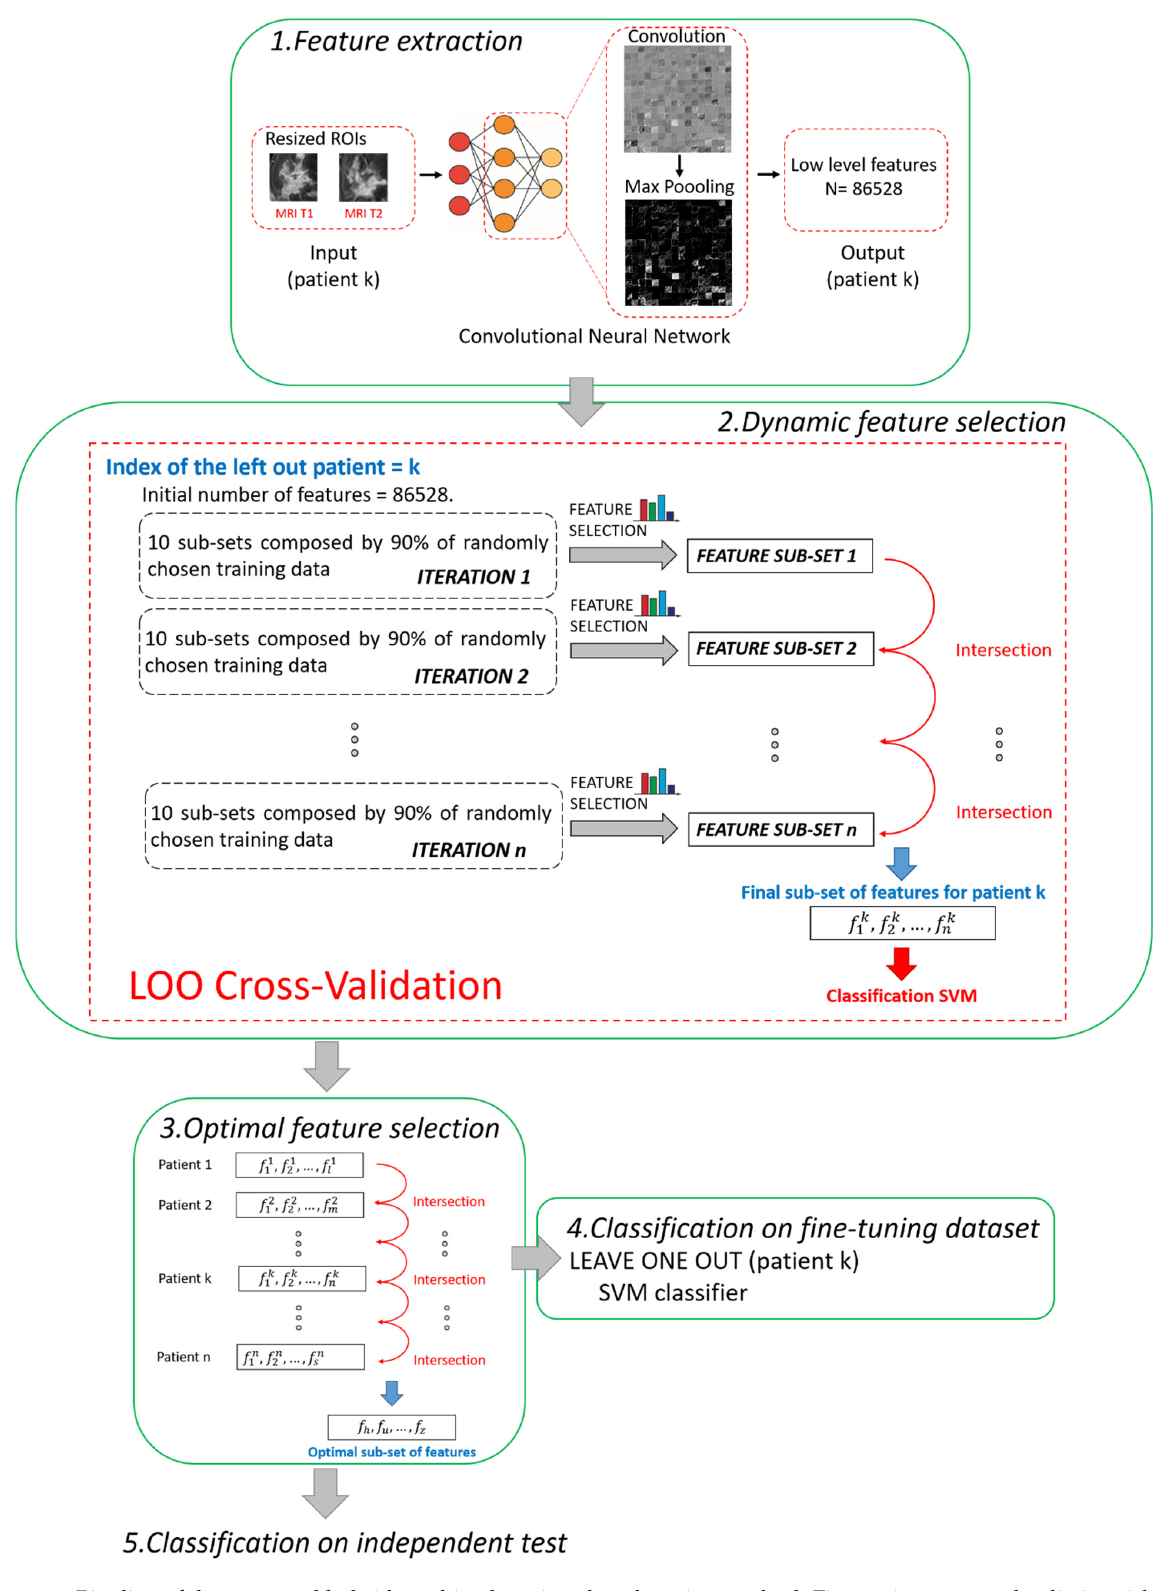
Figure 2. Pipeline of the proposed hybrid machine learning-deep learning method. Five main steps can be distinguished: 1. Feature extraction, 2. Dynamic feature selection, 3. Optimal feature selection, 4. Classification on fine-tuning dataset, 5. Classification on independent test.